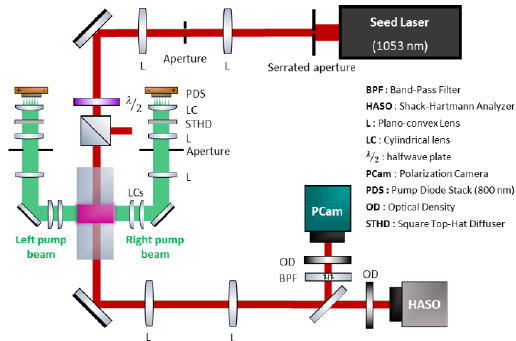
Fig. 2: (Color online) Sketch of the experimental setup. The probe beam is illustrated in red and the pump ones in